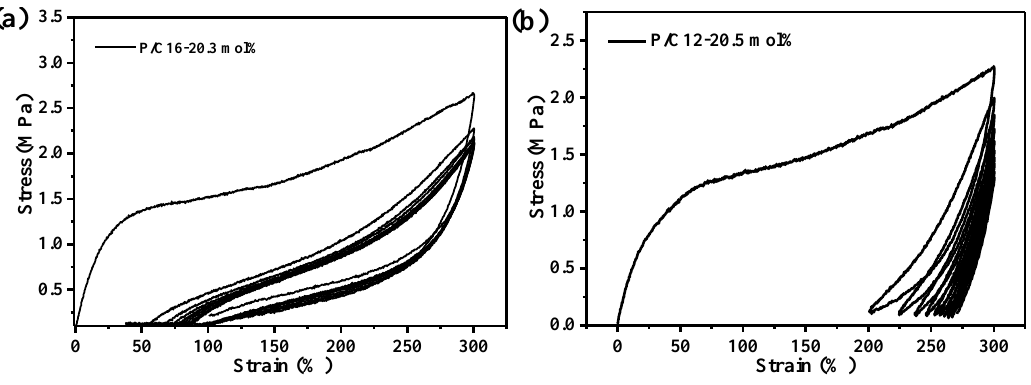
Figure 5. Hysteresis tests for P/C16-20.3 mol.% ( a ) and P/C12-20.5 mol.% ( b ).